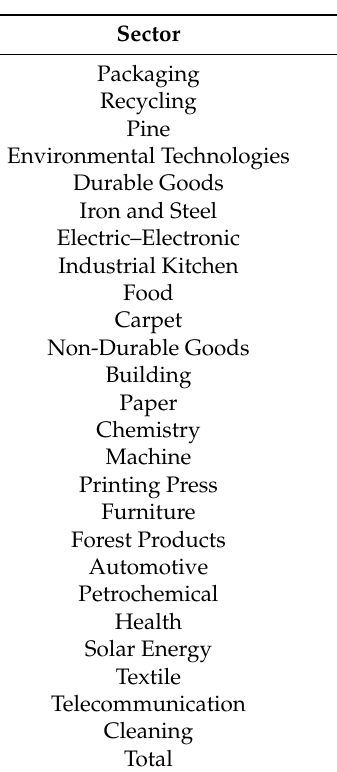
Table 1. Sectoral